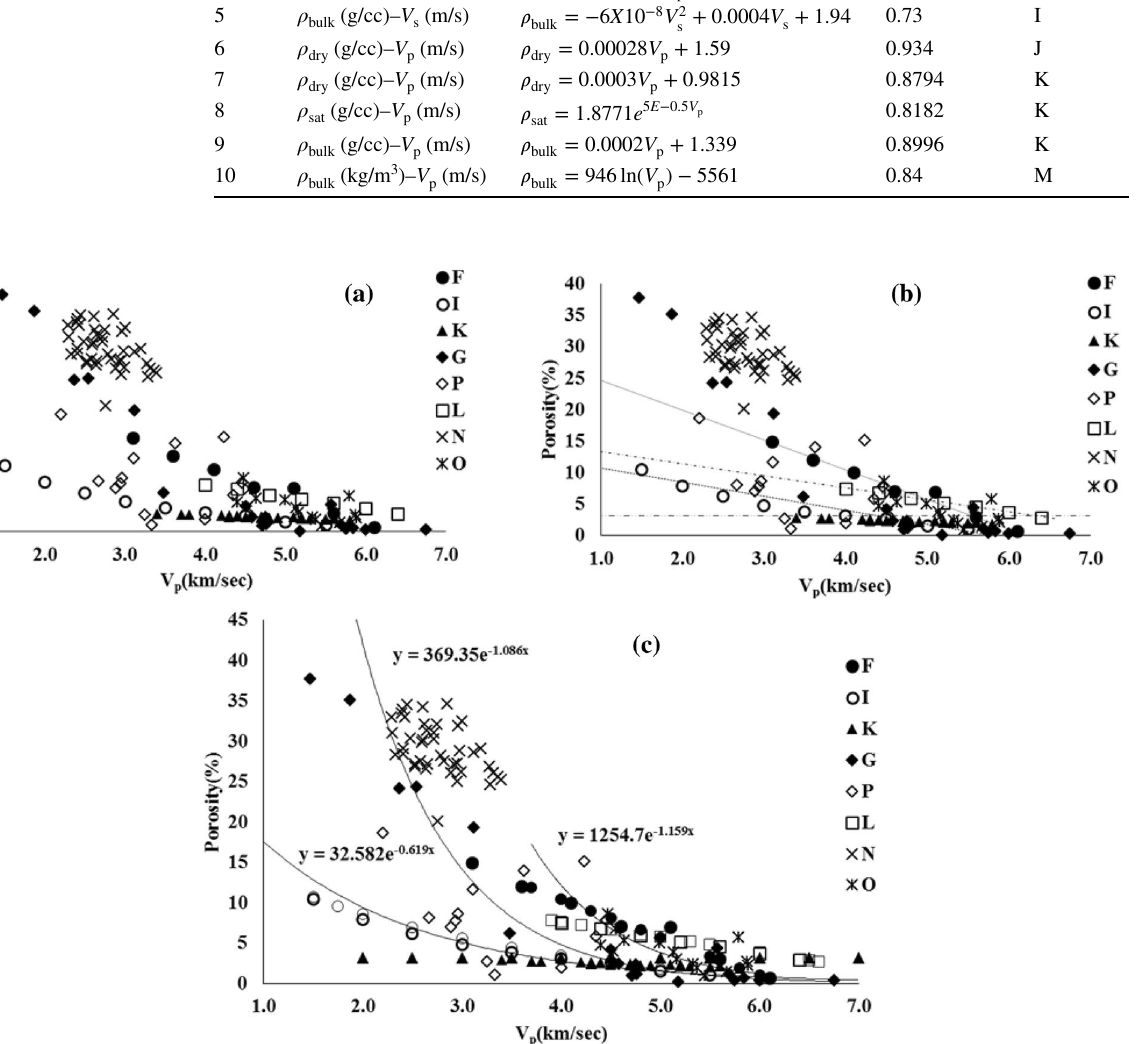
and, c including general trends derived from this study (datasets plot- ted as symbols while solid lines represent proposed general